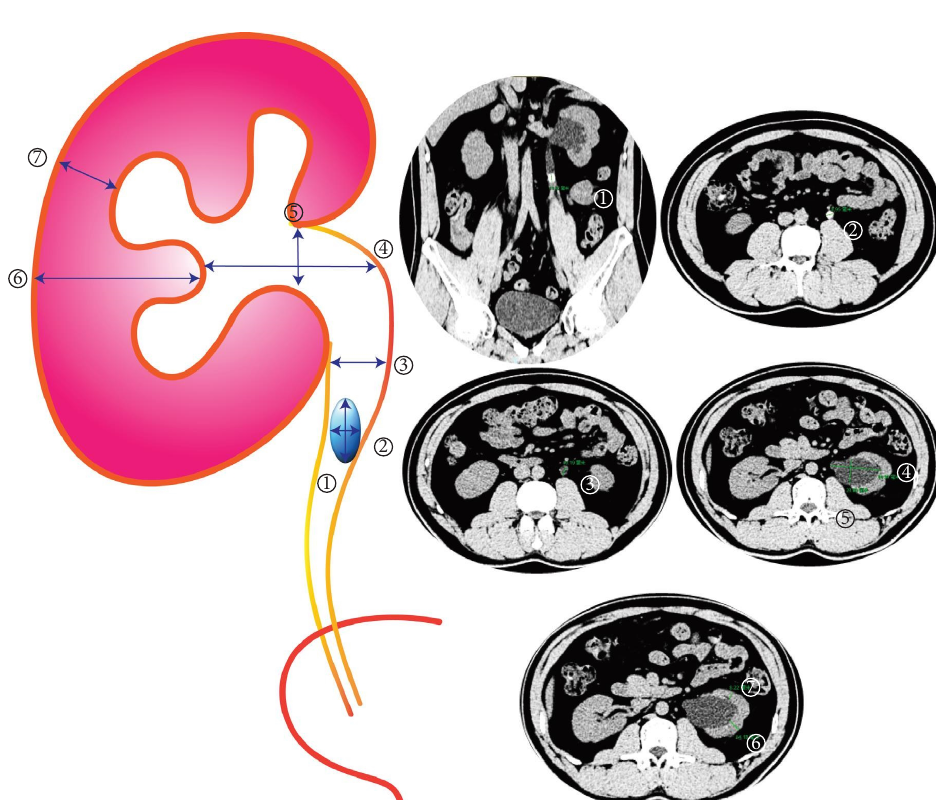
Figure 2: Te computed tomography (CT)-based measurements: ① long diameter of ureteral calculi; ② short diameter of ureteral calculi; ③ ureter diameter at about 1cm above ureteral calculi; ④ long diameter of hydronephrosis; ⑤ short diameter of hydronephrosis; ⑥ diameter of the widest part of the kidney parenchyma; ⑦ diameter of the narrowest part of the renal parenchyma. Te CT-based measurements were measured in a typical case: ① � 11mm, ② � 9mm, ③ � 10mm, ④ � 60mm, ⑤ � 29mm, ⑥ � 14mm, and ⑦ � 8mm; mm: millimeter.